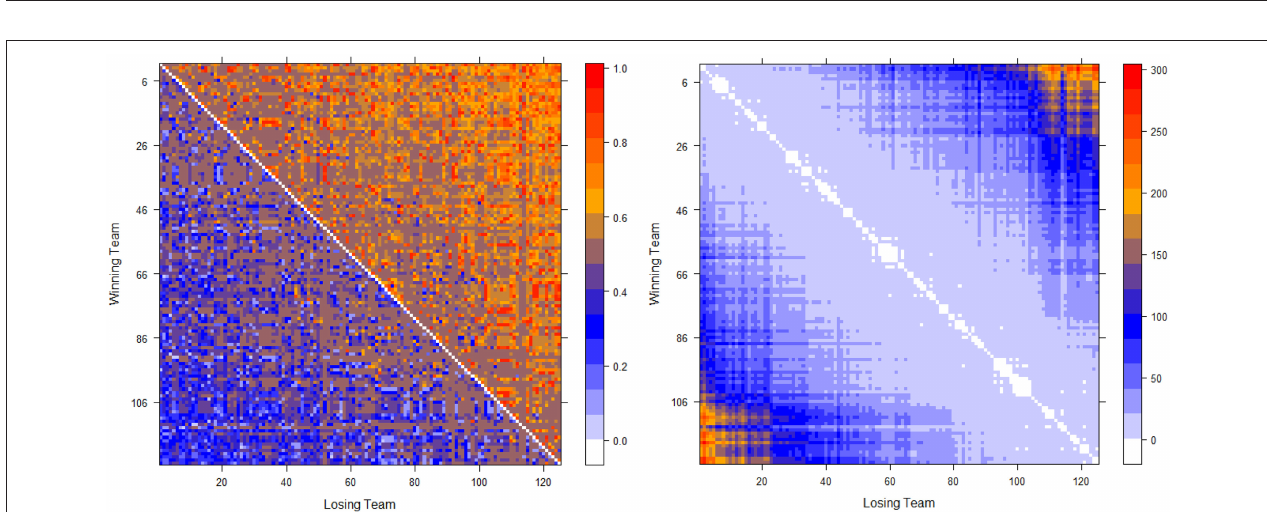
FIGURE 2 | Optimally permuted ˆ P D ( W 0 ) (left panel) and Hamiltonian distance matrix with teams being arranged according to ˆ σ * for the 2012 NCAA football season (right panel).